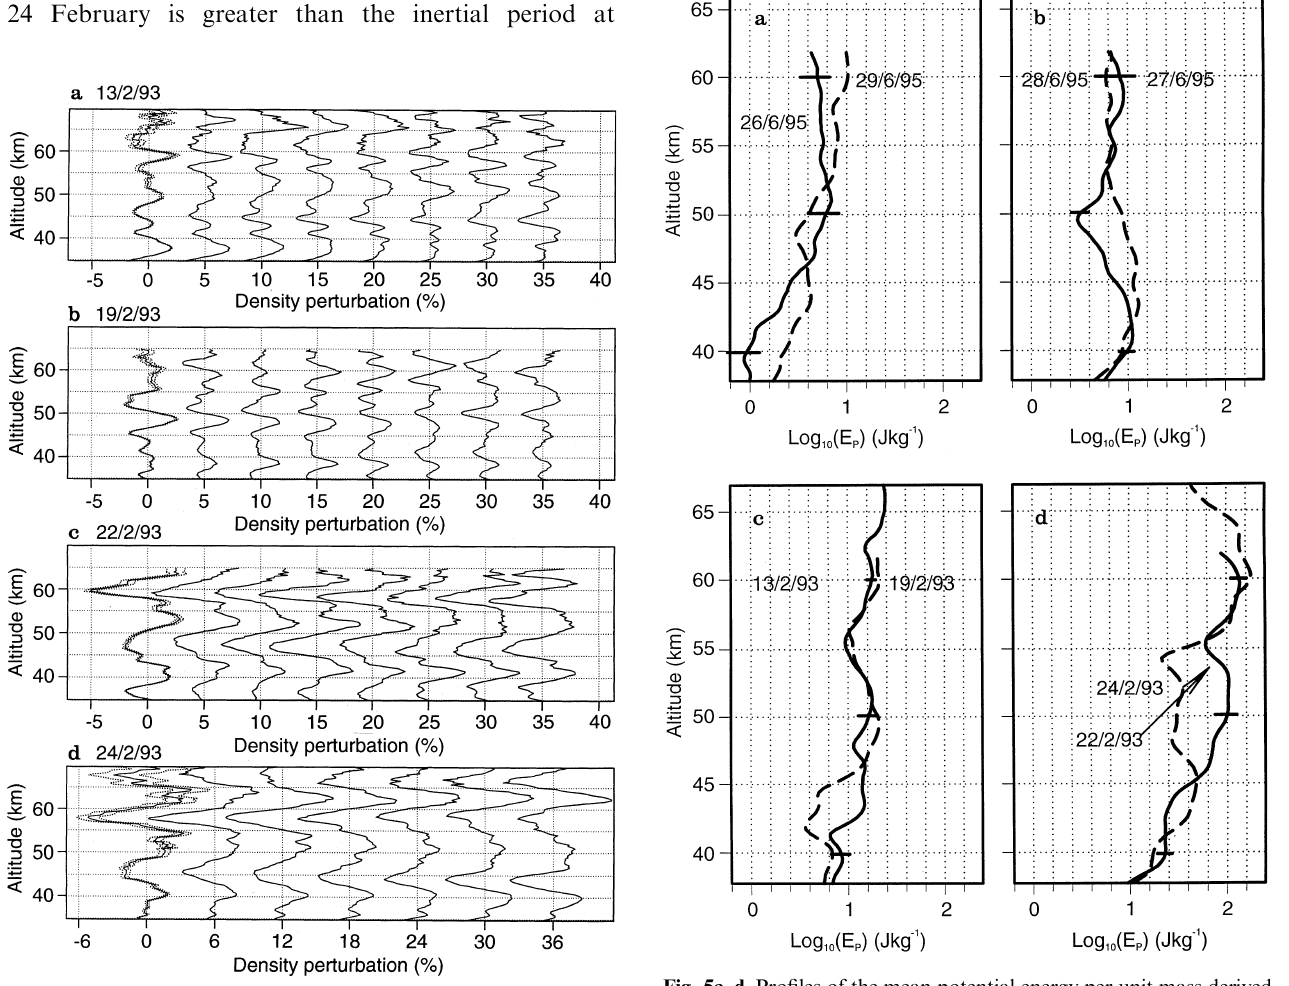
Fig. 4a–d. Profiles of percentage density fluctuations derived from 20- min observations on the nights of a 13, b 19, c 22 and d 24 February 1993, successive profile values being o(cid:128)set by 4% density perturbation for the first three nights and 6% for the fourth night. The estimated uncertainities for the first profile for each night are shown